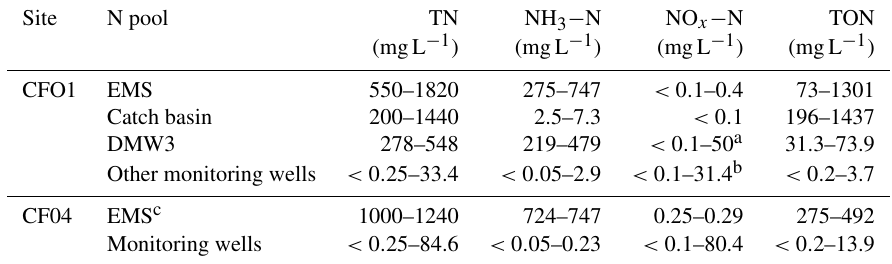
Table 2. Range of measured concentrations of TN, NH 3 − N, NO x − N (NO 2 − N + NO 3 − N), and TON at each study site. At CFO1 results from monitoring well DMW3 are presented separately because values in this well differed substantially from all other